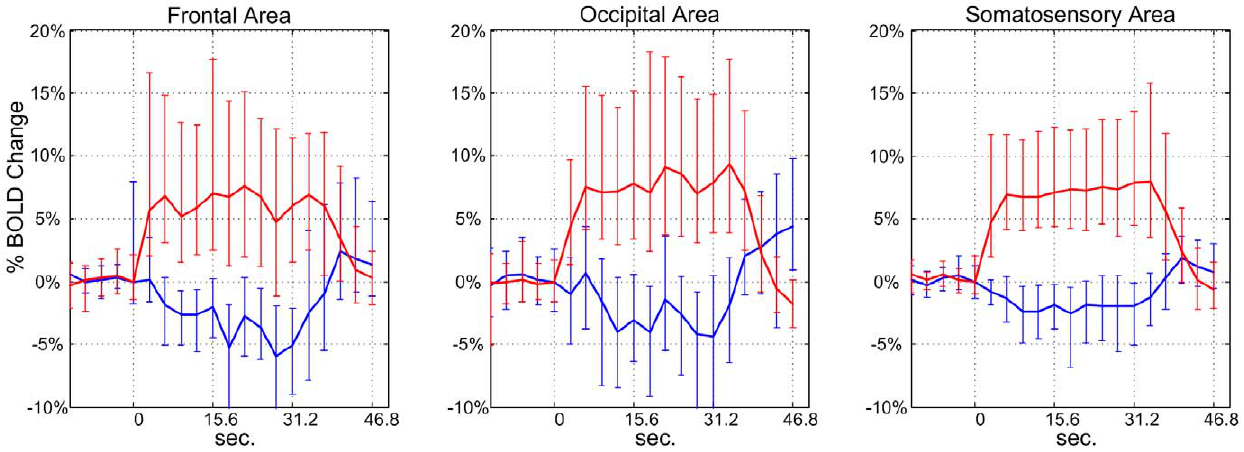
Figure 1. The mean ± s.e.m. of sNBRs and PBRs. The mean 6 s.e.m. of sNBRs and PBRs for bilateral frontal, occipital and somatosensory groups taken from left hand data. The first and last blocks of the task paradigm were excluded from analysis, the three middle blocks for each individual deactivated and activated voxel to generate their mean responses, then the SEM were computed over voxels.